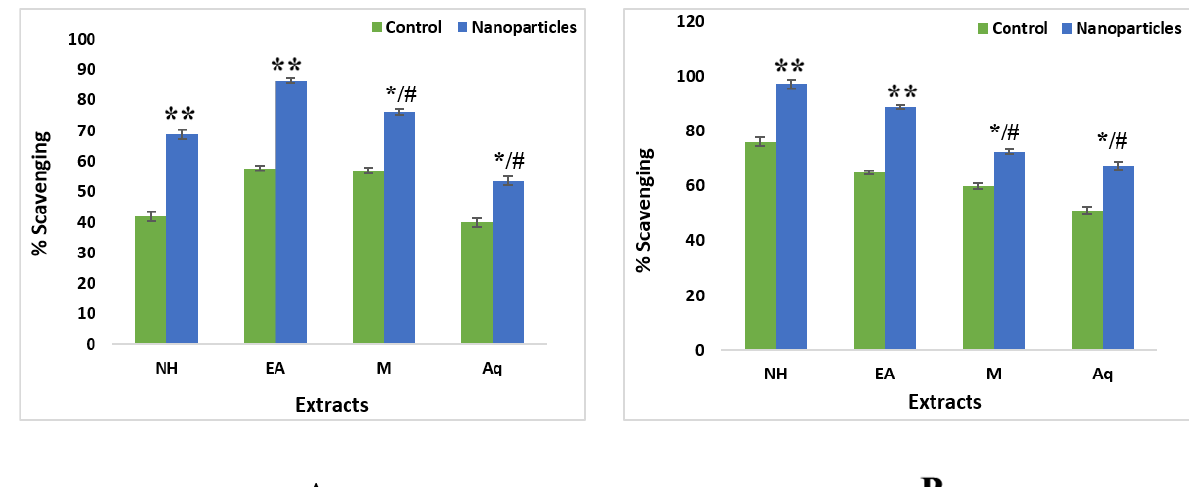
Figure 11. Comparative analysis of antioxidant activity of ZnONPs and crude extracts of different solvents of W. somnifera. ( A ) From Leaves ( B ) From Roots. Data are expressed as the mean ± SD. */# p < 0.05, ** p < 0.01.